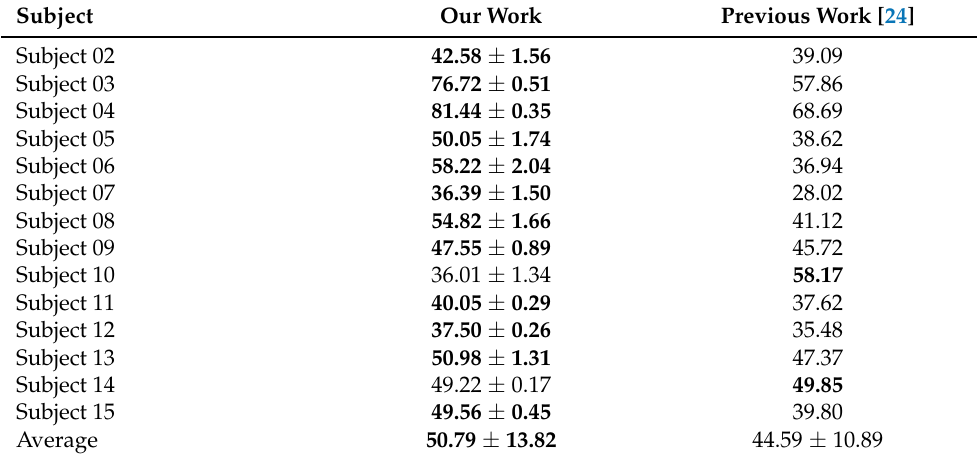
Table 4. Final accuracy of the model for each subjects. Bold entries represent the best accuracy for that subject. Higher is better.